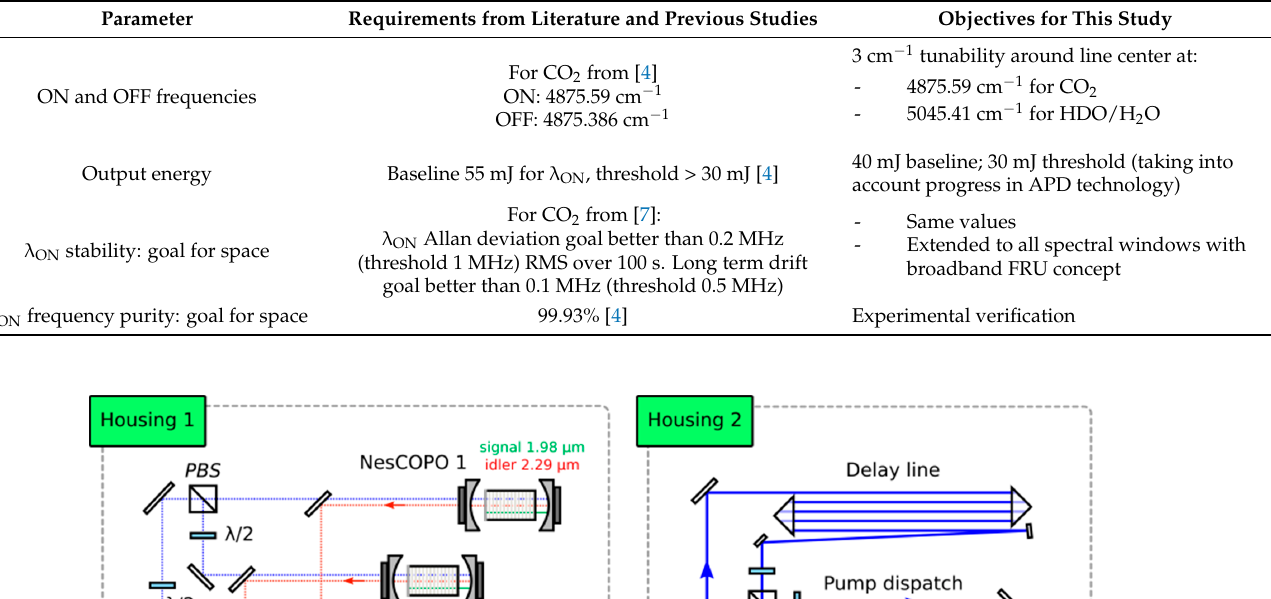
Table 1. Laser transmitter specifications from [4,7] for spaceborne measurement, estimated using a 1.2 m diameter telescope, an optical filter bandwidth of 1 nm, a receiver transmittance of 0.64, a pulse pair repetition rate of 50 Hz, a detector noise √ equivalent power of 100 fW/ Hz, an integration time of 160 ns, and a spacecraft altitude of 350 km.